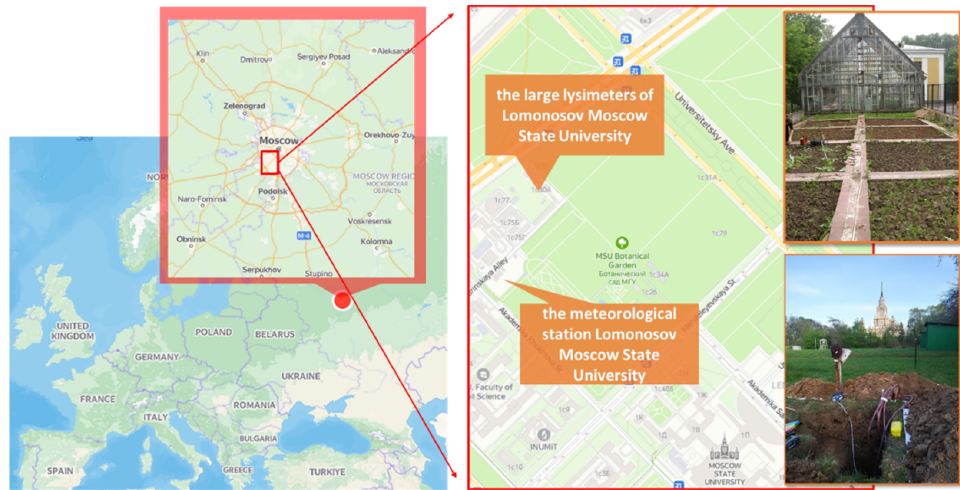
Figure 1. Location and appearance of lysimeters.